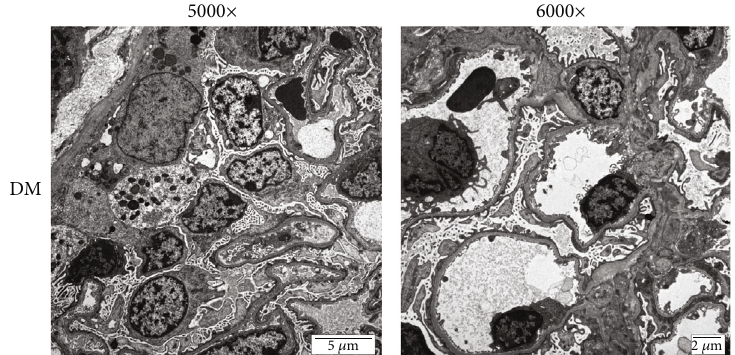
Figure 2: Electron microscope results of the kidneys of minipigs (magni fi cation: 5000 × and 6000 ×